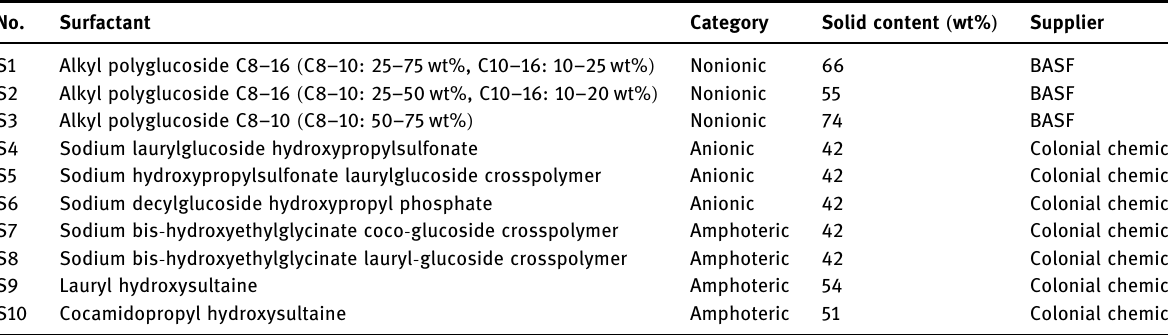
Table 1: List of surfactants